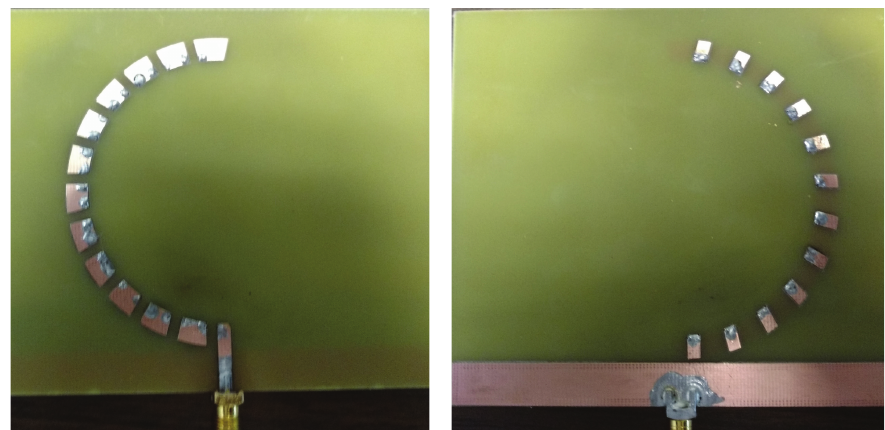
Figure 11: Prototype